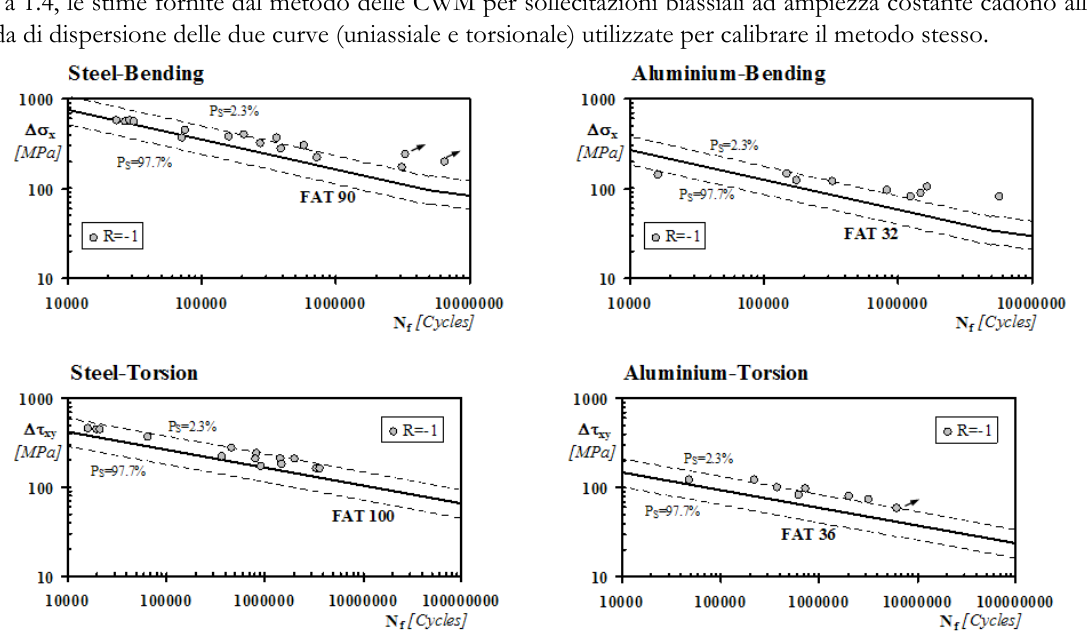
Figura 4: Confronto fra le curve di normativa IIW [10] ed i risultati sperimentali di [5,